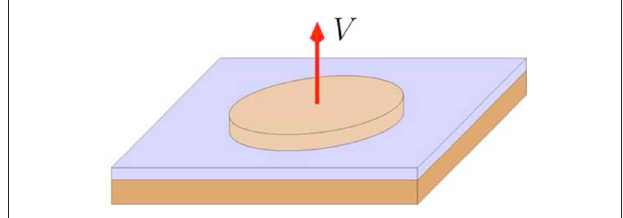
FIGURE 1 | Setup: negative squeeze motion of flat circular